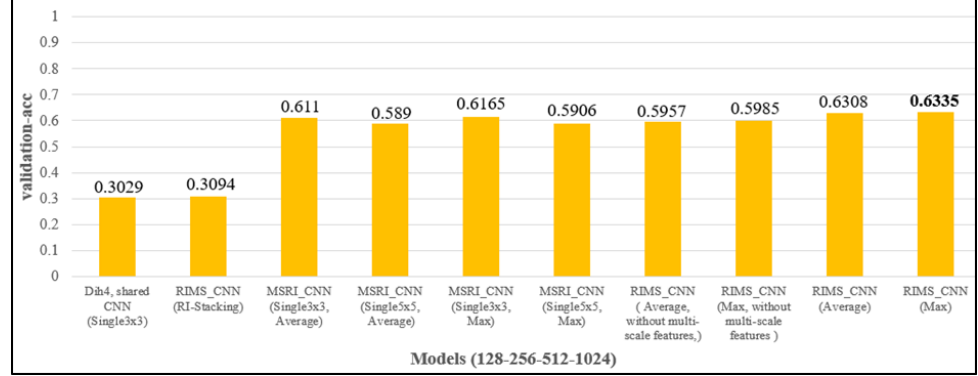
Figure 26. Evaluating different feature-extracting structures on the fixed-angle rotated CIFAR-10.